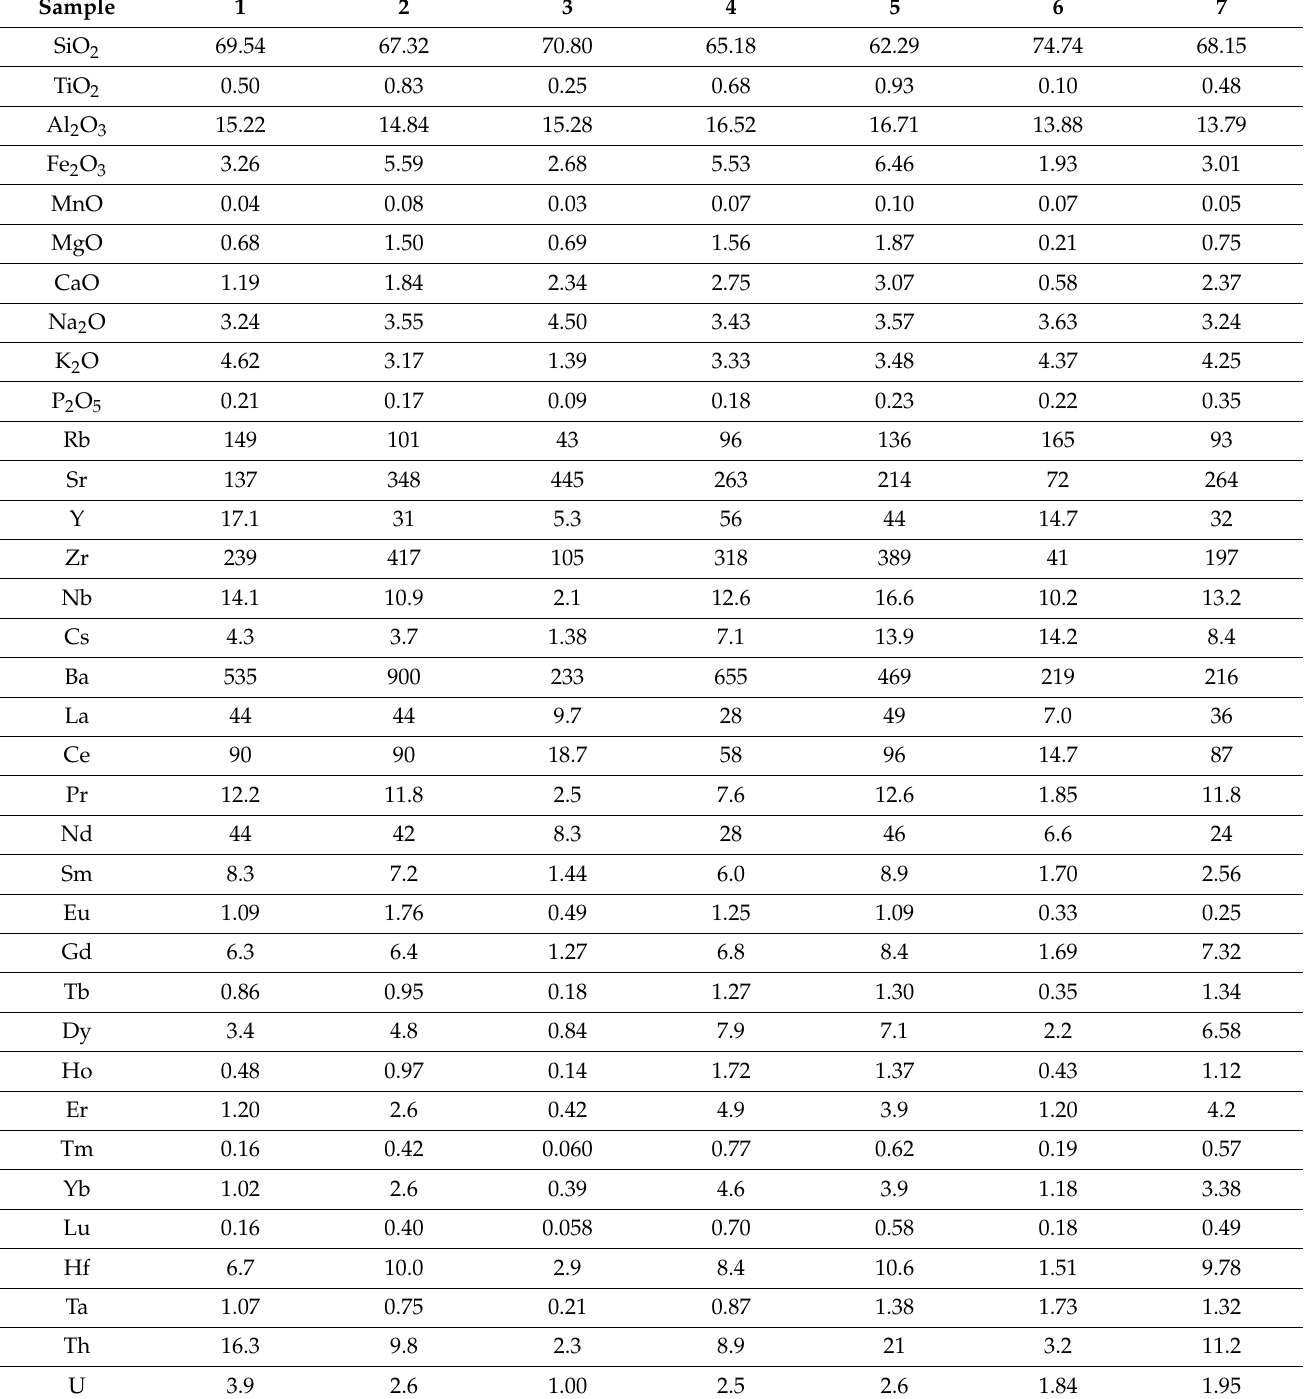
Table 2. Summary of the wells of Burabay granitoid-rock mass